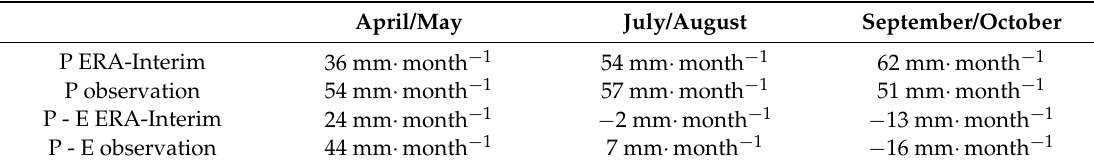
Table 5. Monthly precipitation P and fresh water budget P - E of ERA-Interim compared to collocated observations based on all collocated